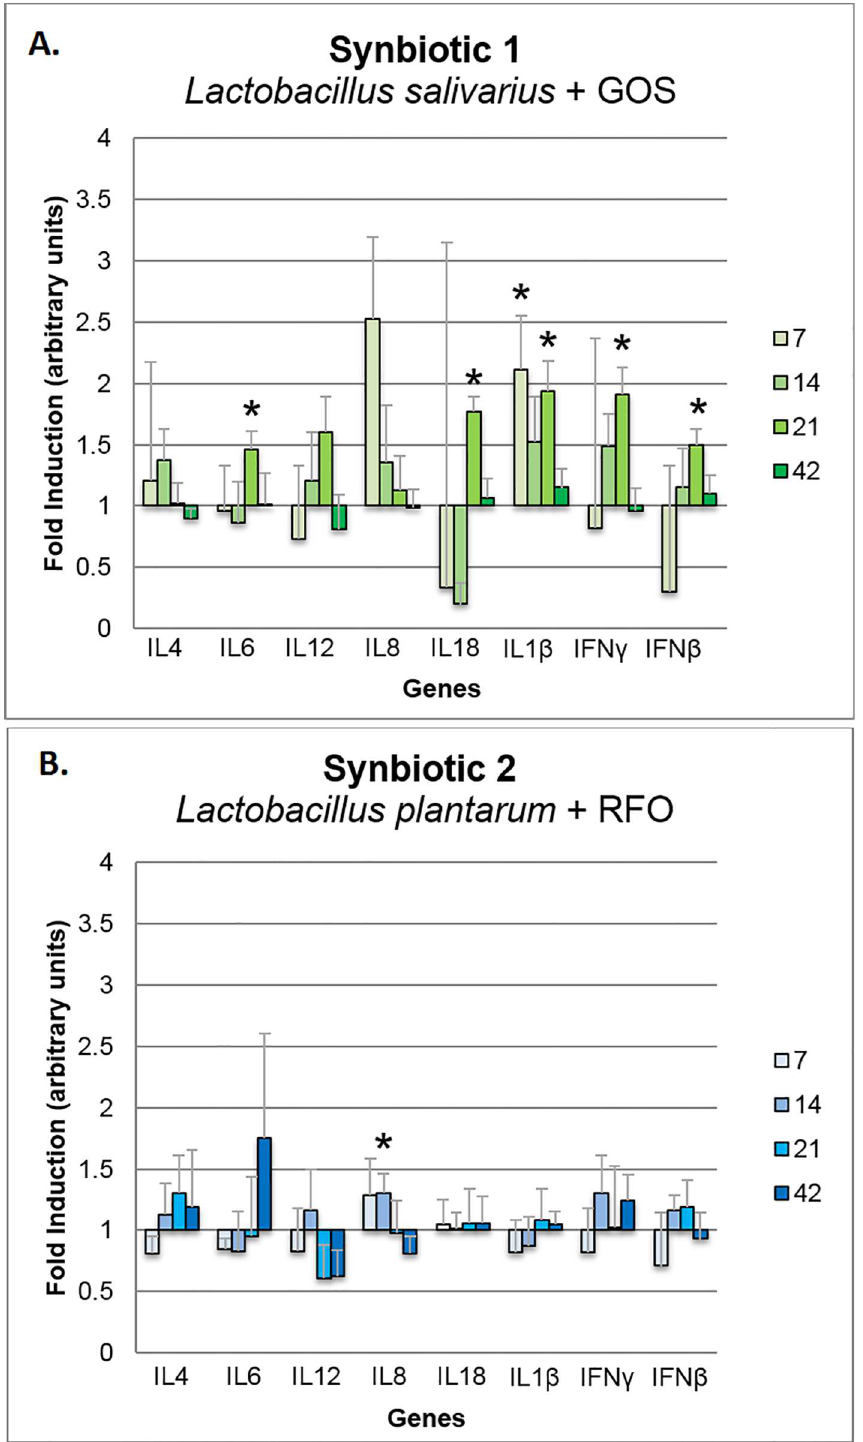
Fig 4. Changes in relative expression of the immune-related panel of genes in the spleen of broiler chickens injected in ovo with the synbiotics (A) Lactobacillus salivarius with GOS and (B) Lactobacillus plantarum with RFO. Analysis was performed using the ΔΔ Ct method to determinefold induction. Synbioticswere injected on day 12 of embryonic development. Sampling days were 7, 14, 21, and 42 days post hatching. Statistical analysisconsisted of comparing the experimental groups with the